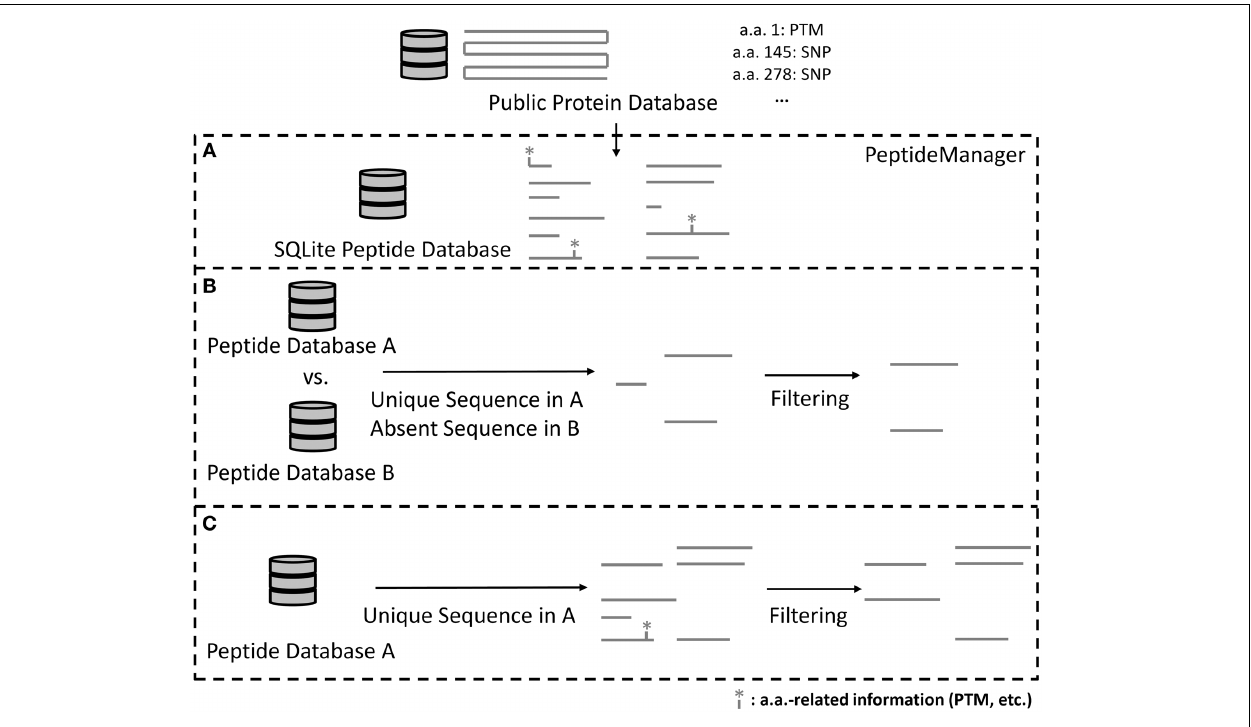
FIGURE 2 | Scheme illustrating how PeptideManager is operating. Required information from the public database is extracted to produce the peptide database (SQLite format) (A). Created peptide databases are stored and can be used for peptide selection queries (B,C) . The peptide selection